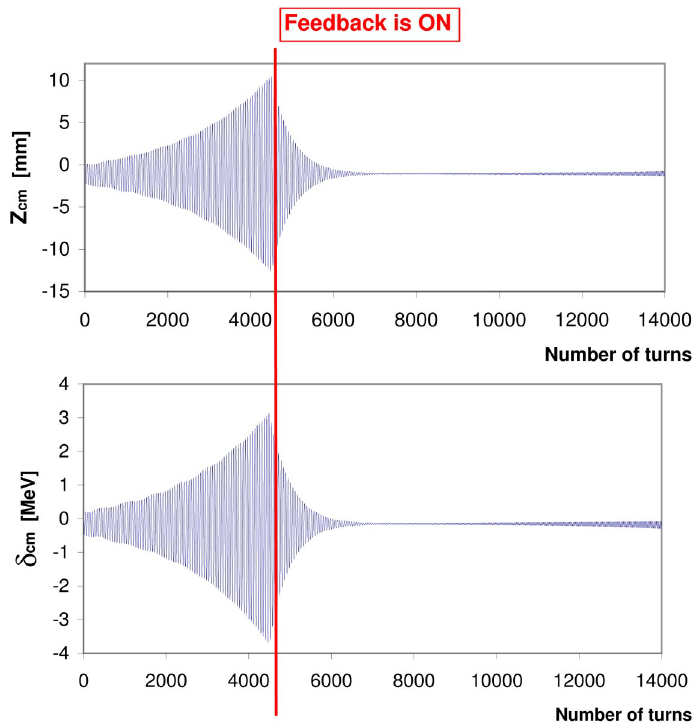
FIG. 9. (Color) Variation of the centroid offset Z Planck equation with the feedback